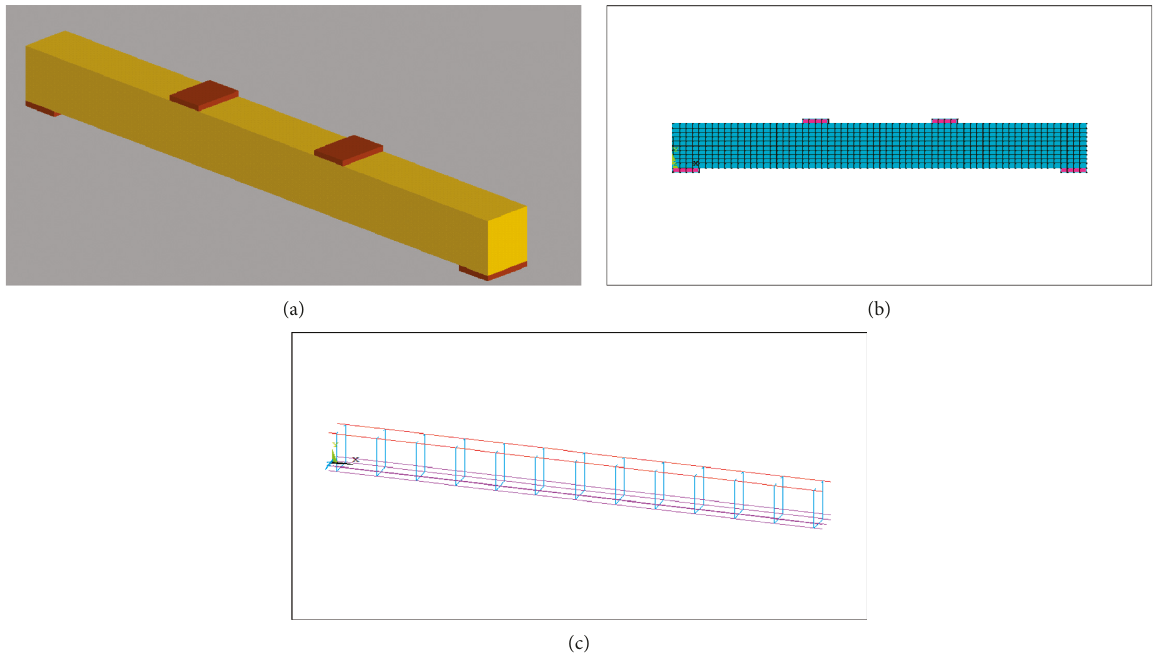
Figure 3: 3D view of the (a) RC beam model and (b) mesh model and (c) 3D configuration of reinforcements.